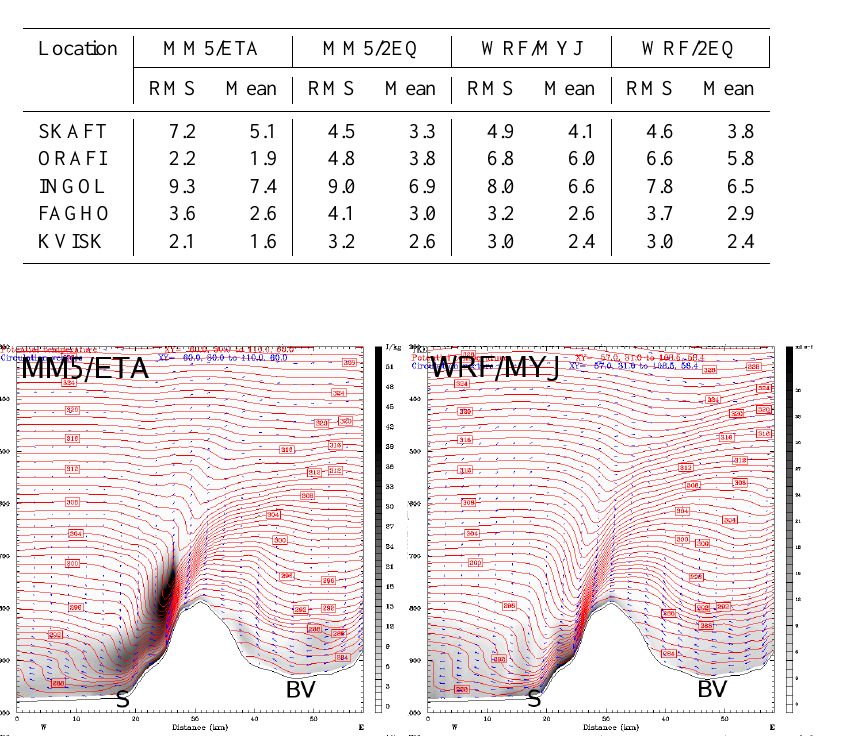
Table 2. Root mean square (RMS) and mean errors [ms − 1 ] of simulated wind speed at stations SKAFT, ORAFI, INGOL, FAGHO and KVISK.